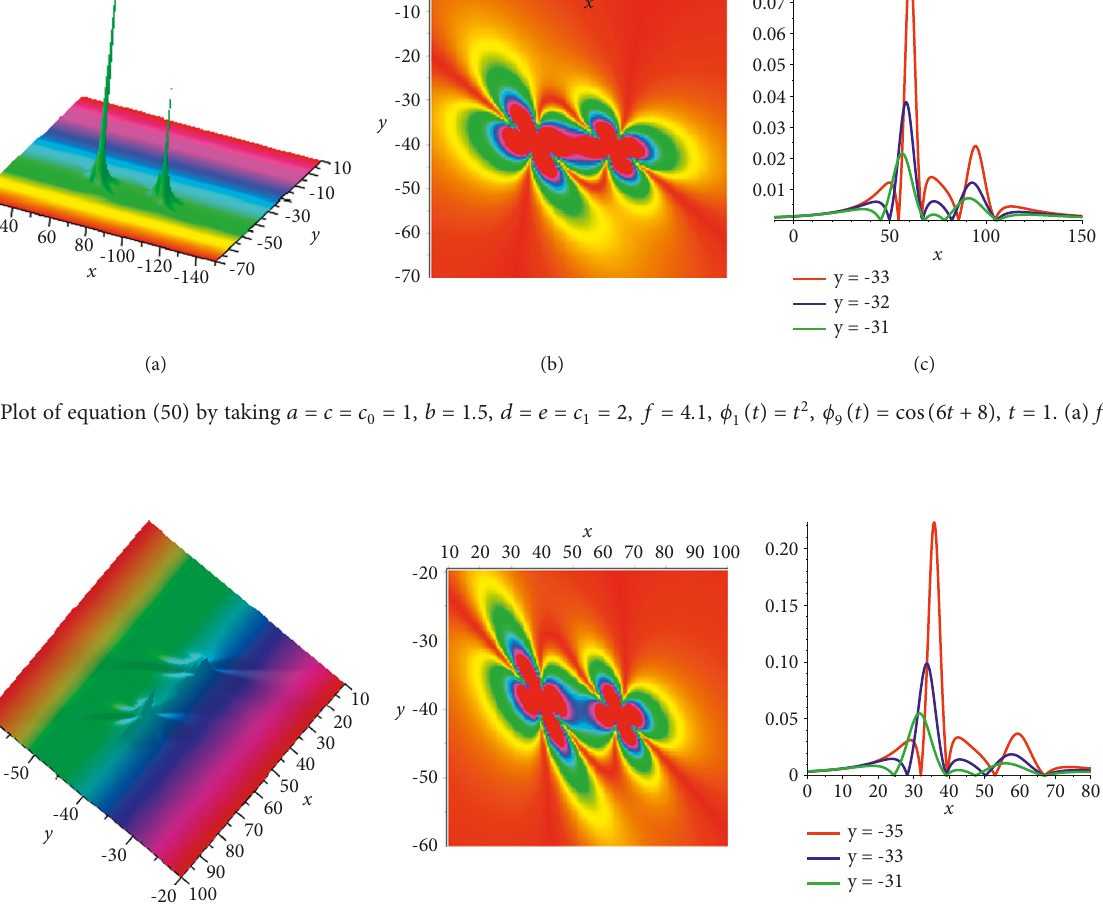
� 1 , b � 1 . 5 , f � 4 , c 0